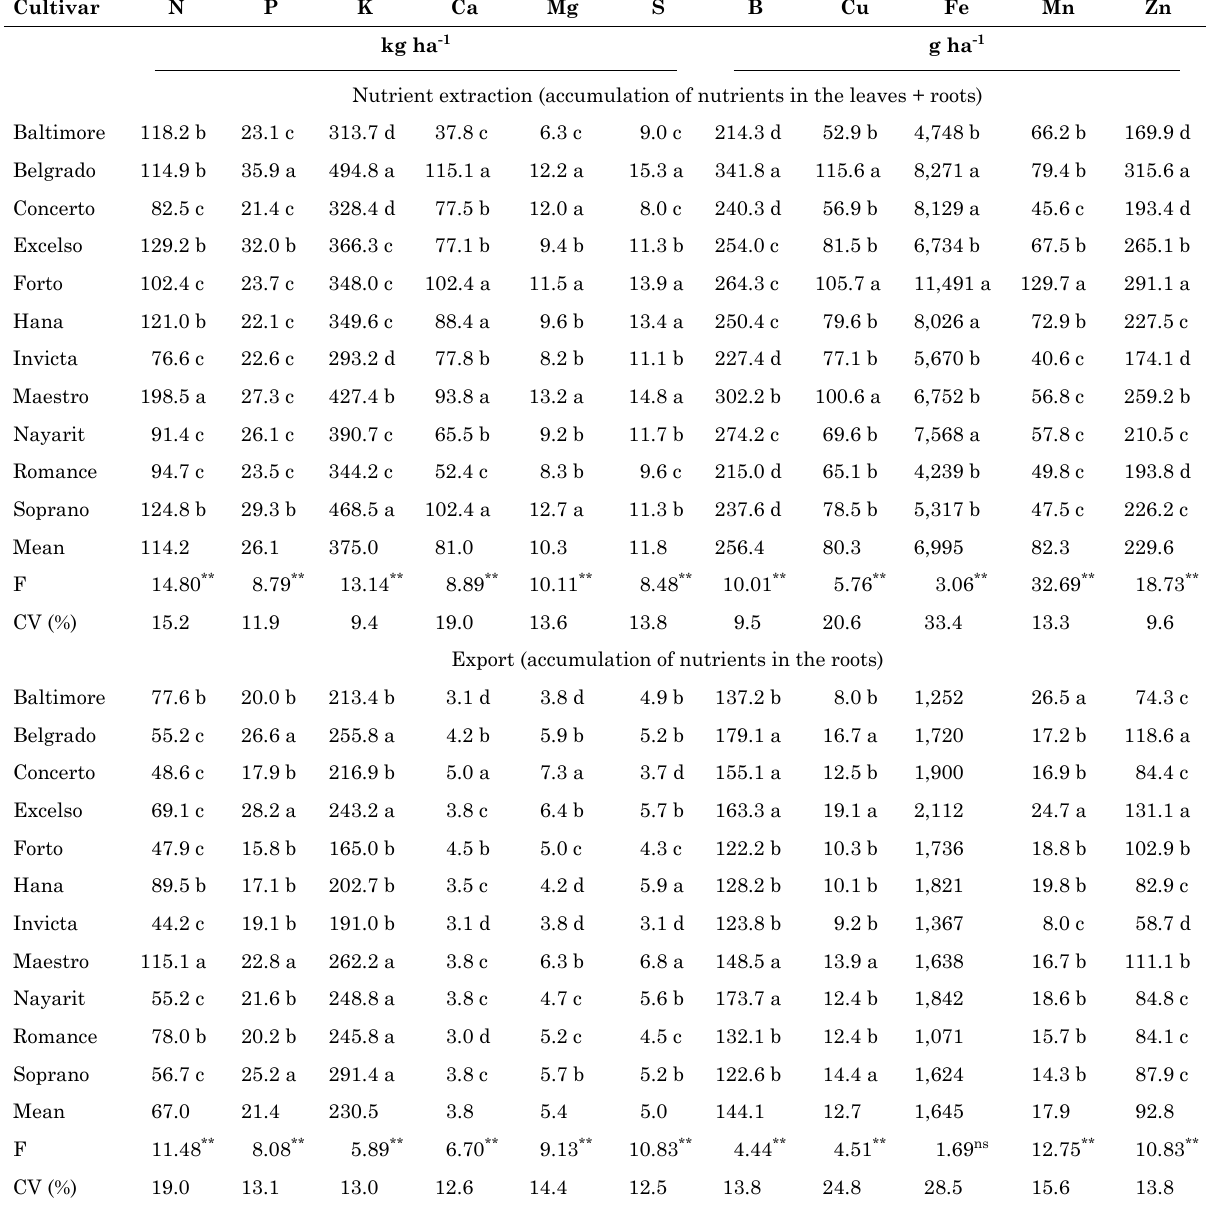
Table 8. Nutrient extraction and export by winter carrot cultivars sown in the summer-winter transition crop season (Experiment